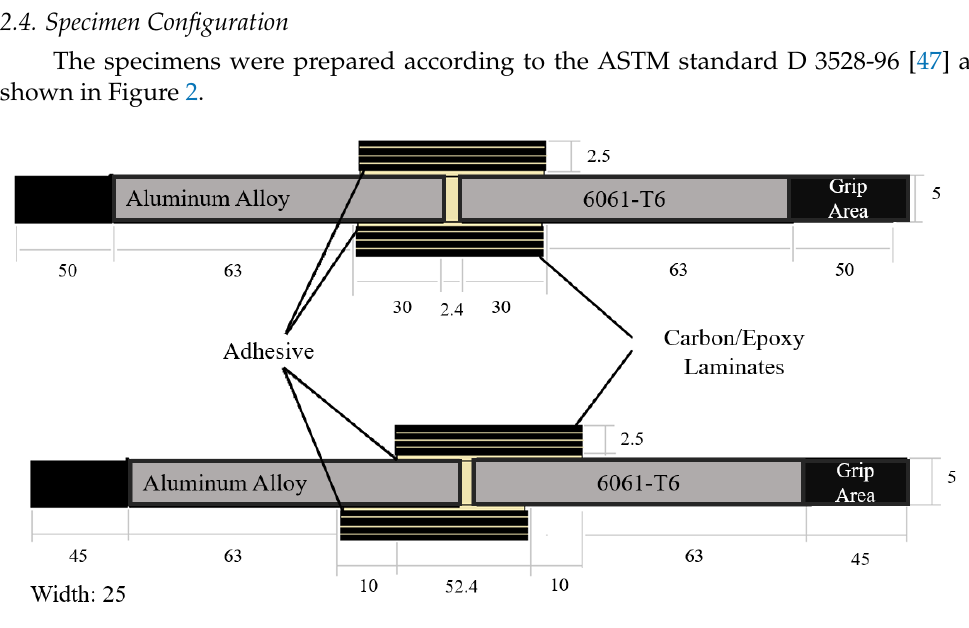
Figure 2. Double strap match and mismatch lap joint between aluminum and carbon fibers (all the dimensions are in millimeters).